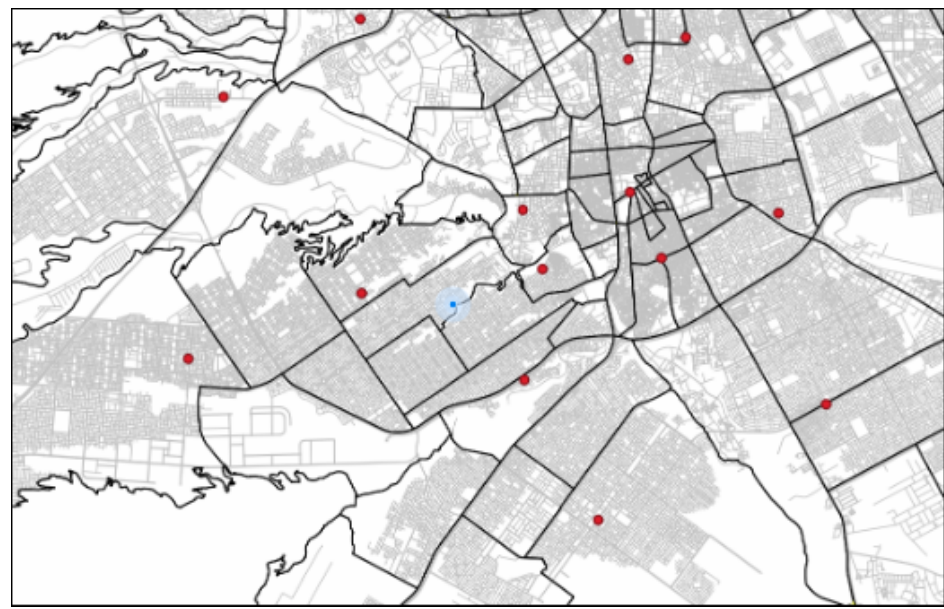
Figure 8. Catchment area of the emergency locations.